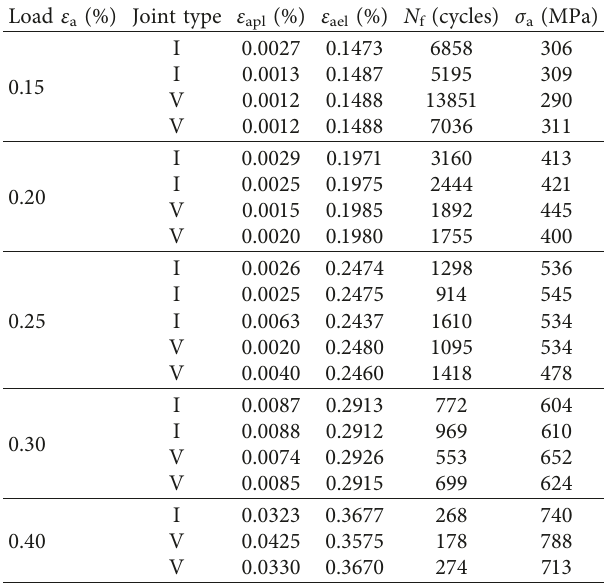
Table 4: Results of fatigue tests for welded joints of S960QL steel.